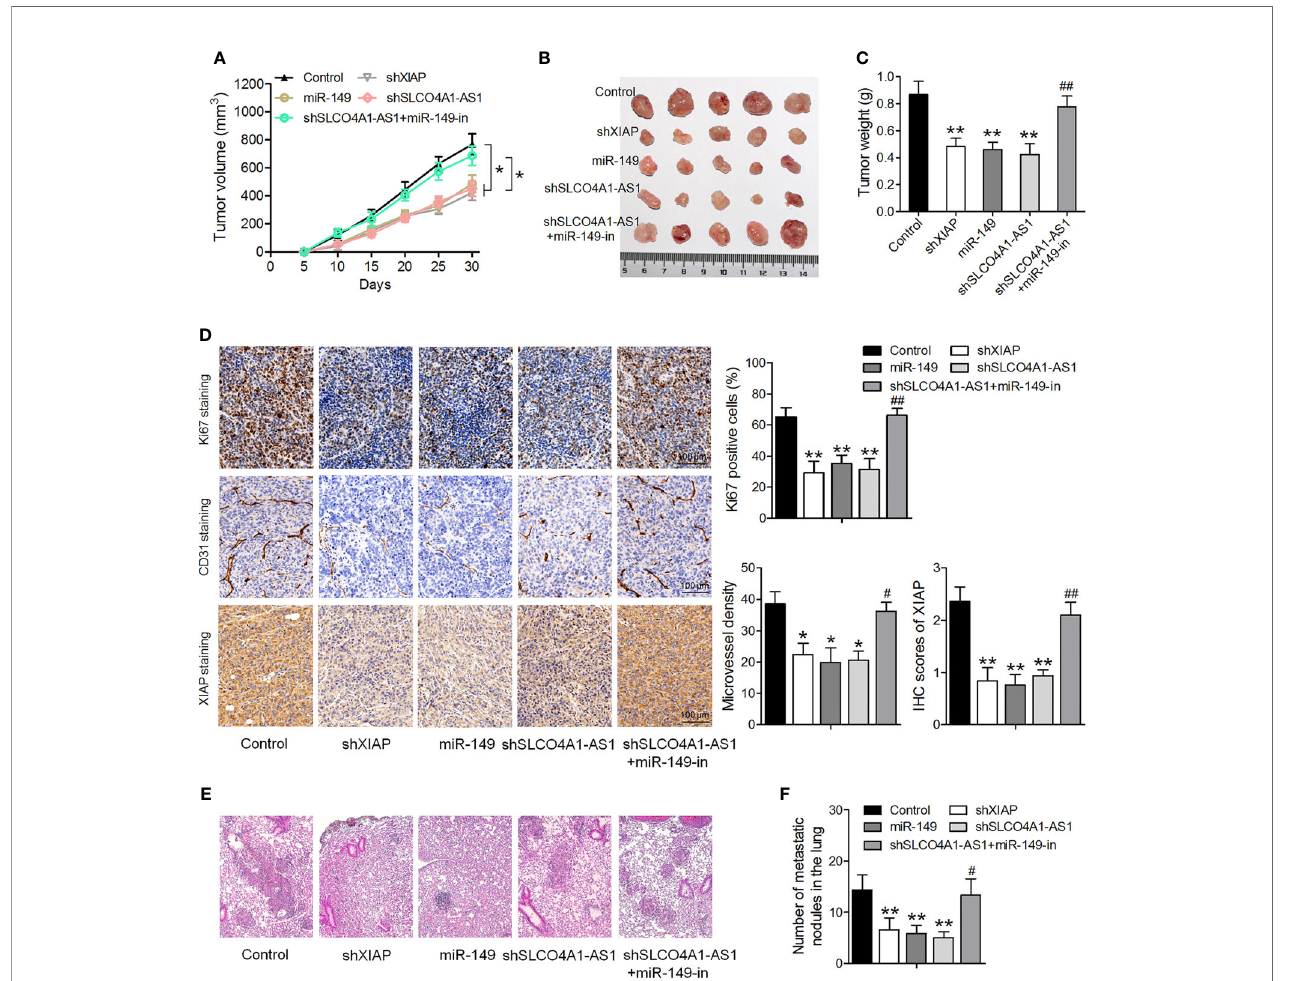
FIGURE 6 | Downregulation of SLCO4A1-AS1 suppresses tumor growth and metastasis in vivo . (A, B) Nude mice were injected with MKN45 cells infected with XIAP shRNA, miR-149 mimic, SLCO4A1-AS1 shRNA, and SLCO4A1-AS1 shRNA plus miR-149 inhibitor. Tumor growth curves after subcutaneous injection and images are shown. (C) Tumor weights. (D) Immunohistochemical staining of Ki67, XIAP, and CD31 in the tumors. (E) Experimental metastasis in the animal model was conducted by injecting vector-transfected MKN45 cells into the tail vein of the nude mice. Visualization of the H&E-stained lung sections. (F) The numbers of tumor nodules on lung surfaces from different groups were observed. * P < 0.05, ** P < 0.01 vs. control group. # P < 0.05, ## P < 0.01 vs. shSLCO4A1-AS1